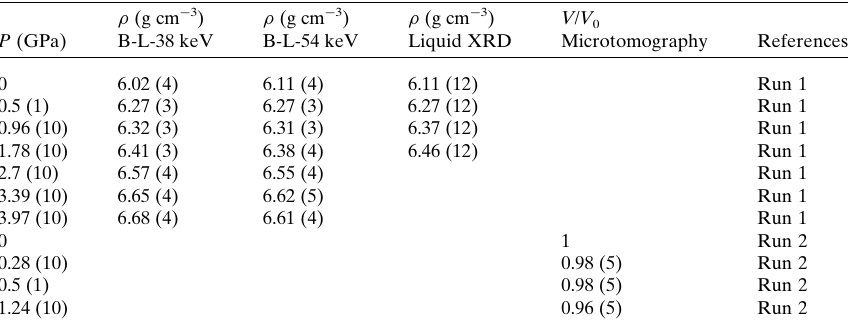
Table 1 Summary of density measurements. B-L-38 keV and B-L-54 keV stand for Beer–Lambert measurements at indicated